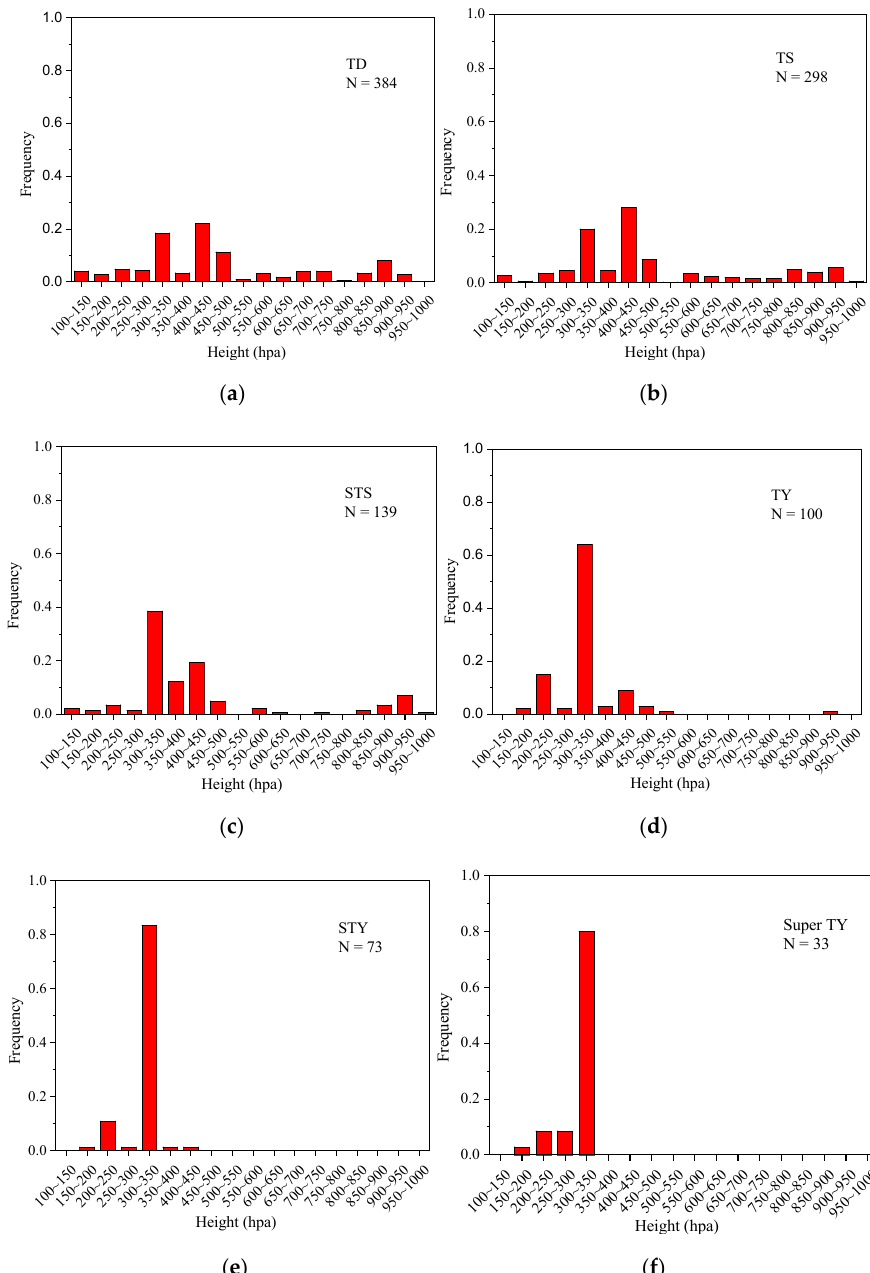
Figure 4. Warm-core height for different TC intensities: ( a ) TD, ( b ) TS, ( c ) STS, ( d ) TY, ( e ) STY, and ( f ) Super TY.